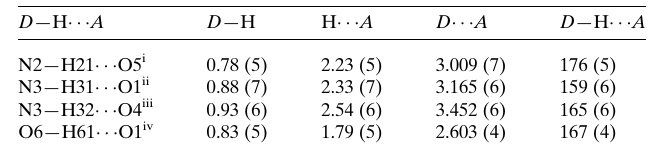
Table 1 Hydrogen-bond geometry (A˚ , (cid:4) ).